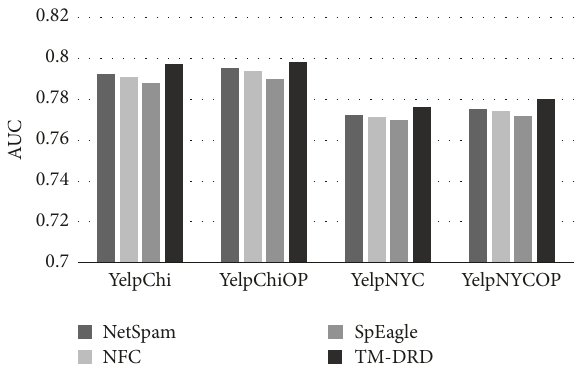
Figure 9: The AUC for TM-DRD and SpEagle, NFC, and NetSpam in different datasets.